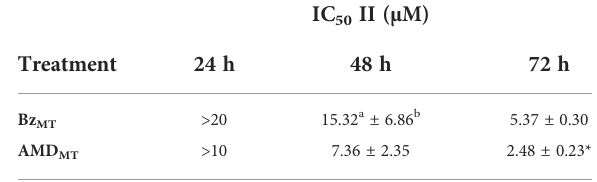
TABLE 1 Trypanocidal effect of Bz and AMD in monotreatment on the intracellular forms of T. cruzi -infected HCs.